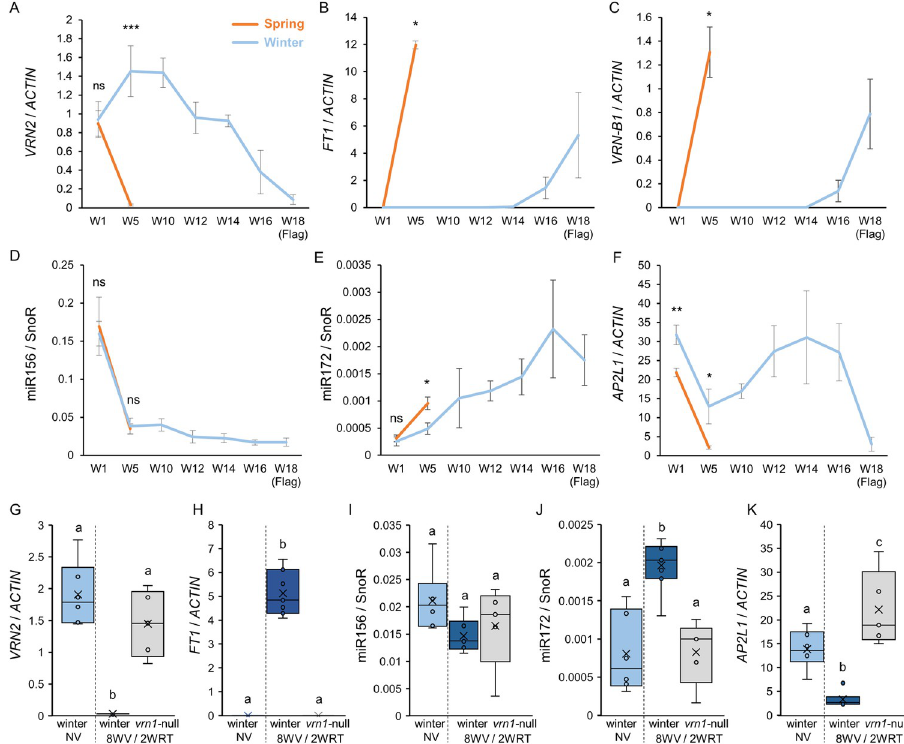
Fig 5. Effect of vernalization and VRN1 expression on the transcript levels of flowering genes, miR156 and miR172 in spring and winter wheat. (A-F ) Time-course expression levels determined by qRT-PCR in leaves of spring (orange) and winter (blue) Kronos plants grown under LD conditions in the absence of a vernalization treatment. W1 = week 1, 1 st leaf; W5 = week 5, 7 th leaf; W10 = week 10, leaves 10 th -11 th ; W12 = week 12, leaves 13 th -14 th ; W14 = week 14, leaves 15 th -16 th ; W16 = week 16, leaves 18 th -19 th ; W18, week 18, flag leaves (20 th -23 rd ). In both genotypes the fully expanded 7 th leaves were collected during the 5 th week. However, leaf samples were not collected on the same day (34 days for spring and 36–38 days after planting for winter). ACTIN was used as internal reference for ( A ) VRN2 , ( B ) FT1 , ( C ) VRN1 , and ( F ) AP2L1 , and SnoR for ( D ) miR156 and ( E ) miR172. � = P < 0.05, �� = P < 0.01, and ��� = P < 0.001 in t -tests (A, D-F) and non-parametric Kruskal-Wallis tests (B and C) comparing expression at the same leaf in spring and winter Kronos plants. ( G-K ) Box plots showing the expression levels of VRN2 ( G ), FT1 ( H ), miR156 ( I ), miR172 ( J ) and AP2L1 ( K ) determined by qRT-PCR in the 7 th leaf of winter Kronos plants without vernalization, and the 7 th leaves of winter Kronos and vrn1 -null mutants that were vernalized for 8 weeks and then moved to room temperature for two weeks. Samples from the 7 th leaf were collected when the leaves were fully expanded. ACTIN was used as internal references for VRN2 , FT1 and AP2L1 , and SnoR for miR156 and miR172. Data correspond to at least 5 independent biological replicates. Different letters above the box plots in panels G-K indicate significant differences ( P < 0.05) in Tukey tests, except for pane ( H ), where a non-parametric Kruskal-Wallis test was used (Data E in S1